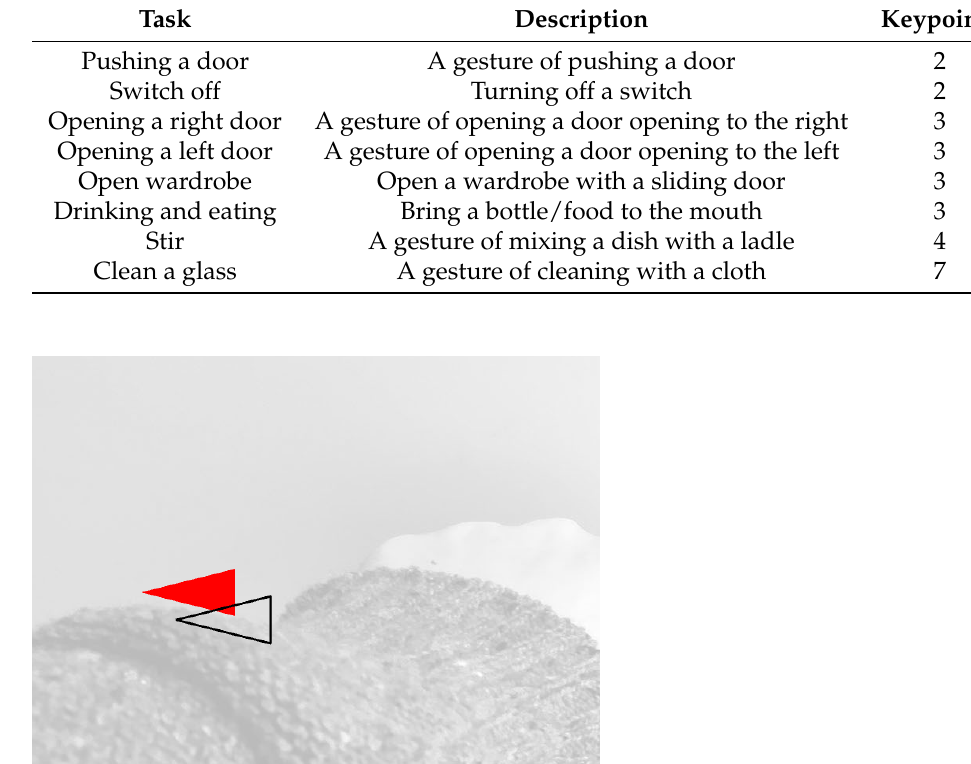
Table 1. List if available tasks.